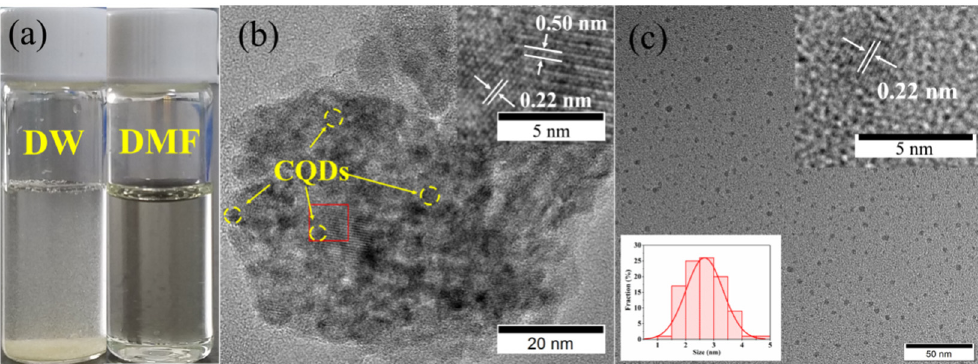
Figure 3. ( a ) Solubility comparison of CQDs/PC in deionized water (DW) and N, N-Dimethylformamide (DMF). ( b ) Transmission electron microscopy (TEM) and high-resolution transmission electron microscopy (HRTEM) images (inset) of CQDs/PC. ( c ) TEM image, the statistical histogram of particle size (the inset on the bottom left corner), and HRTEM image (the inset on the top right corner) of CQDs.